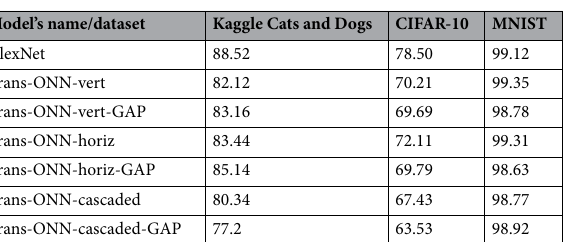
Table 3. Classification accuracy of original test images for different simulation